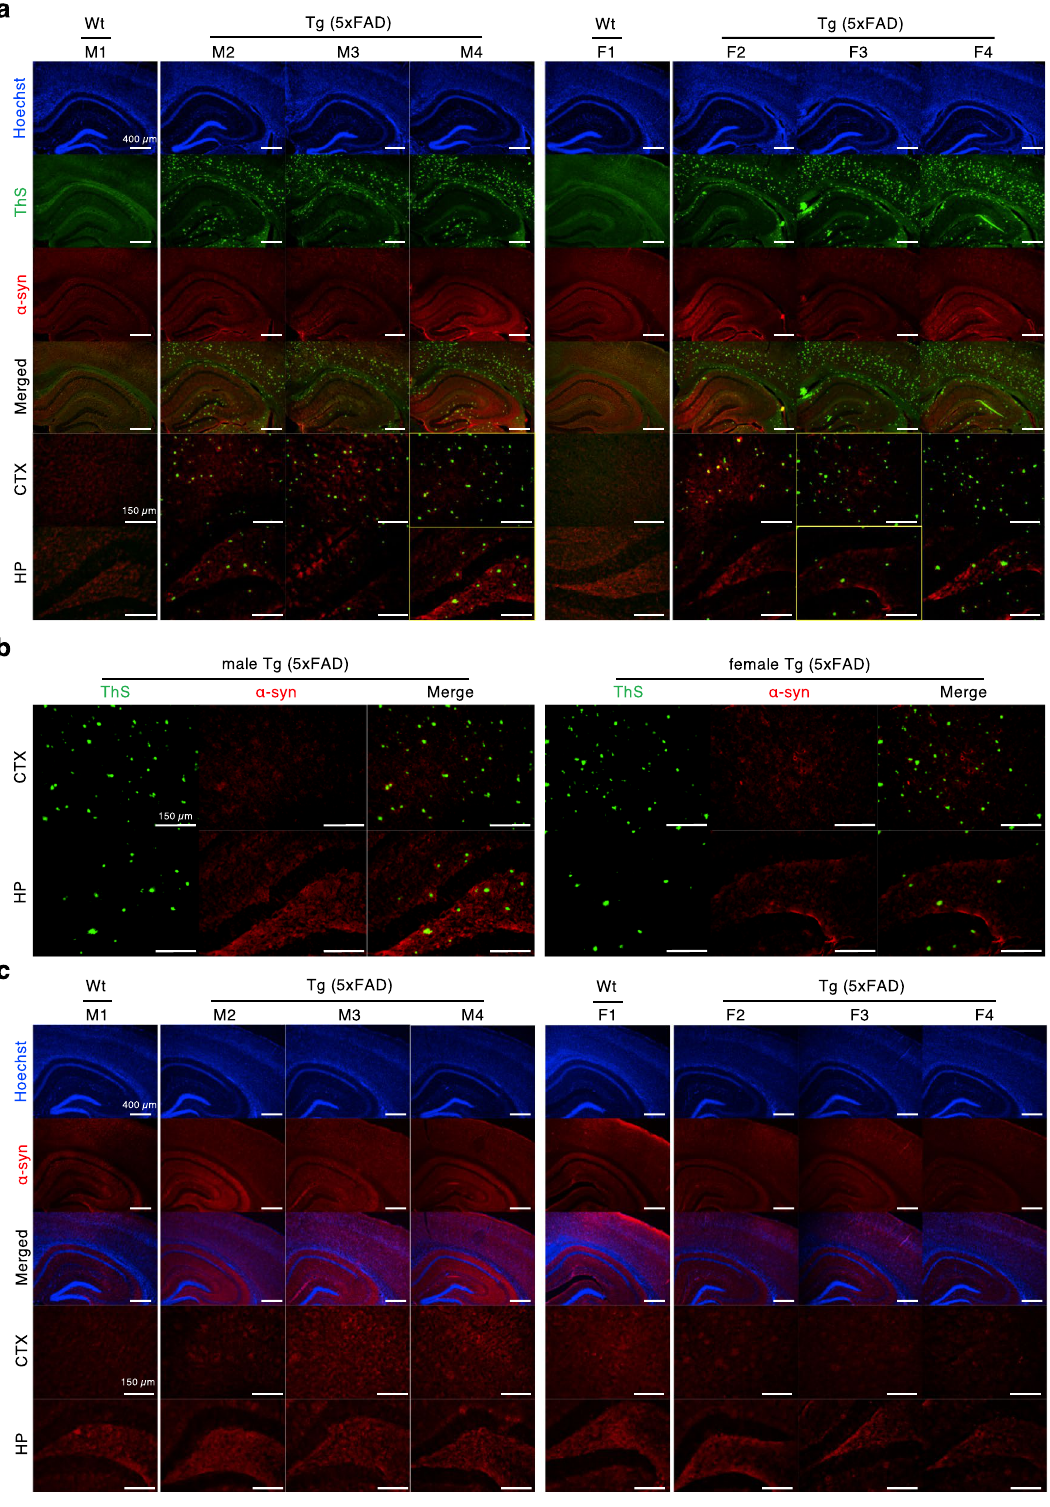
Figure 3. α-Synuclein aggregates were not detected in 5XFAD mice brains. ( a ) The brains were double-stained by Thioflavin S and AT8 anti-α-synuclein antibody. We used male (M2–M4) and female (F2–F4) 5XFAD mice at 7–8 months and 5–6 months of age, respectively. Age- and gender-matched B6SJL wild type male (M1 and F1) was used for a control (scale bars = 400 µm, 150 µm). ( b ) The representative image of ThS- or α-synuclein- stained brains, which is indicated as yellow boxed images in ( a ). Several green dots of ThS fluorescence were observed but no overlapped signal was detected in double-staining by ThS and α-synuclein (scale bars = 150 µm). ( c ) Single-labeling with α-synuclein antibody displayed no remarkable α-synuclein aggregates in 5XFAD mouse brains compared to wild type mouse brains (scale bars = 400 µm, 150 µm). wt, wild type; Tg, transgenic; ThS, thioflavin S; α-syn, α-synuclein; CTX, cortex; HP,